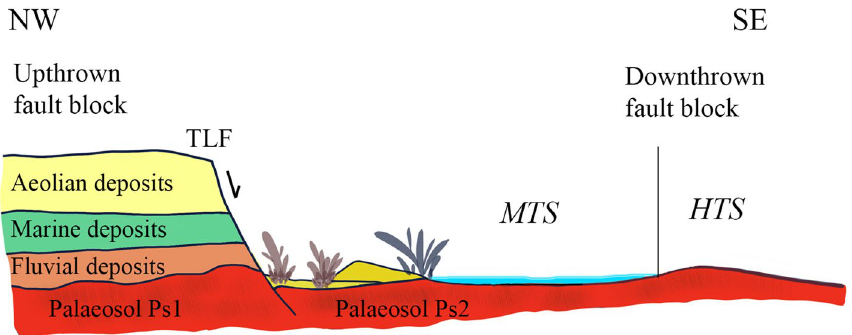
Figure 7. Section showing the stratigraphic order of units exposed in the El Asperillo cliff during the Last Interglacial (OIS5) 22 . Note the wide extension of the palaeosol surface where all hominid (HTS) and other vertebrates (MTS) footprints were recorded. TFL: Torre del Loro